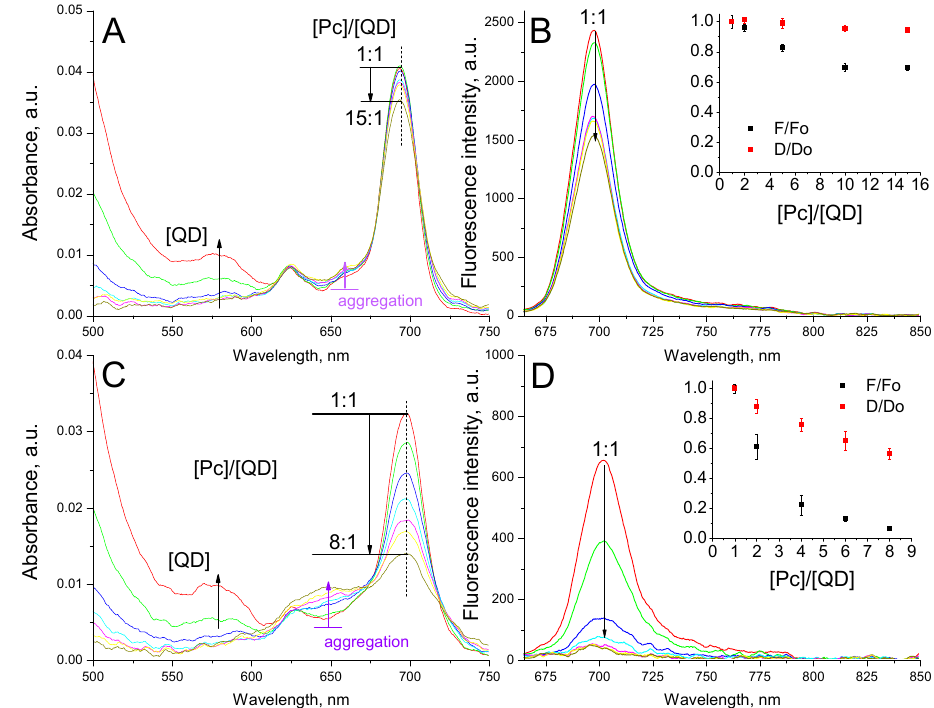
Figure 5. Changes in the absorption and fluorescence spectra of AlPc8 ( A , B ) and ZnPc8 ( C , D ) during an increase in the stoichiometry of the Pc-QD600 conjugate. Insets show the relative change in the absorbance and integral fluorescence of Pc with increasing stoichiometry of the conjugate. The values of D 0 and I 0 were taken for Pc-QD600 conjugate with a 1:1 stoichiometry. Fluorescence excitation wavelength is 655